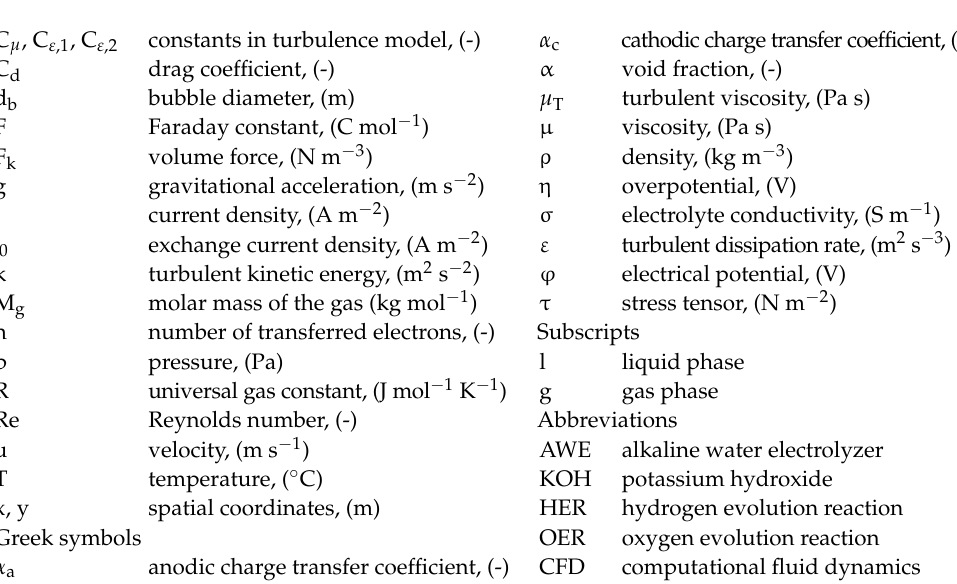
independence. Figure S3: Comparison between the model of this study and the experimental